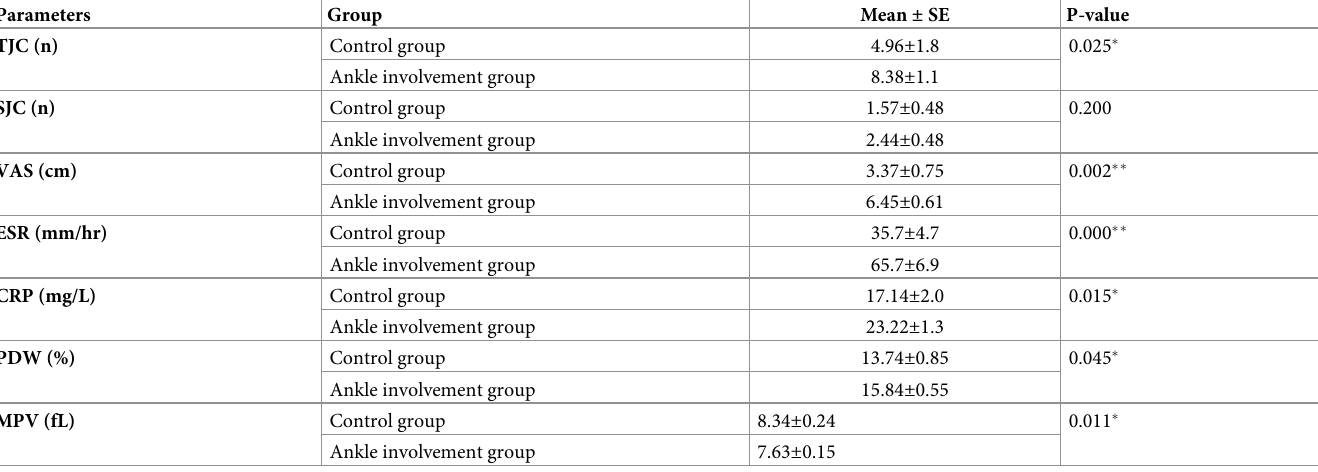
Table 3. Mean ± standard error of the mean (SE) of the EgyDAS and DAS28 parameters for the control group (patients without ankle involvement, n = 23) and ankle involvement group (n = 32) along with the p-value of the independent samples t-test. Parameters